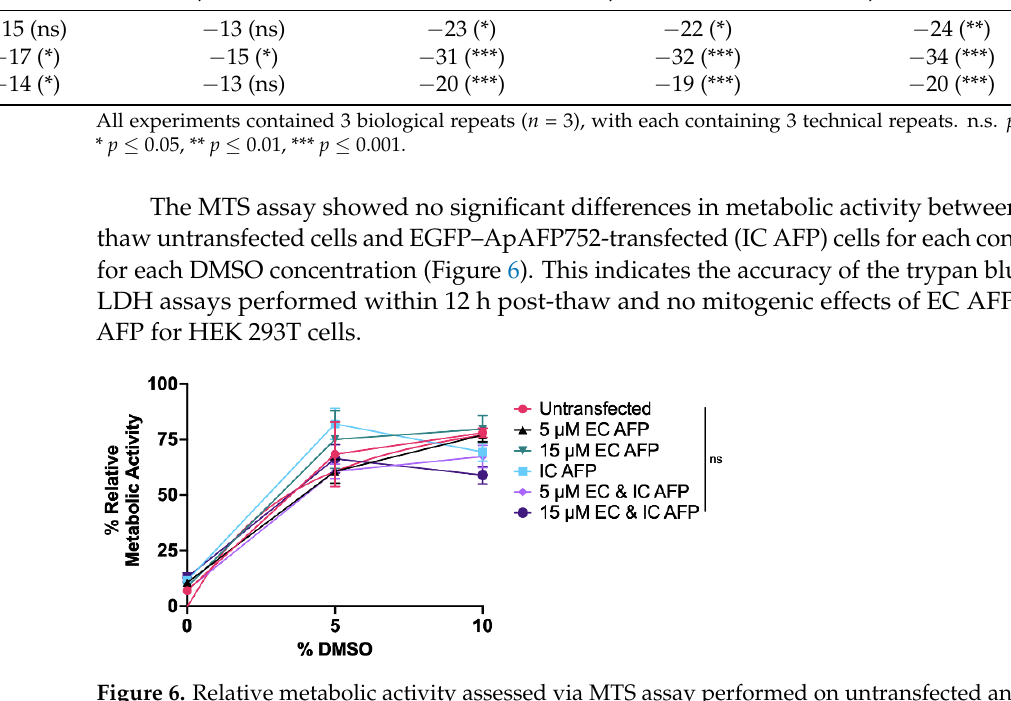
Table 4. Average LDH release of HEK 293T cells expressed as % total cellular LDH across treatments for extracellular (EC) AFP and intracellular (IC) AFP vs. cells without AFP. 5 µ M EC AFP 15 µ M EC AFP IC AFP 15 µ M EC and IC AFP